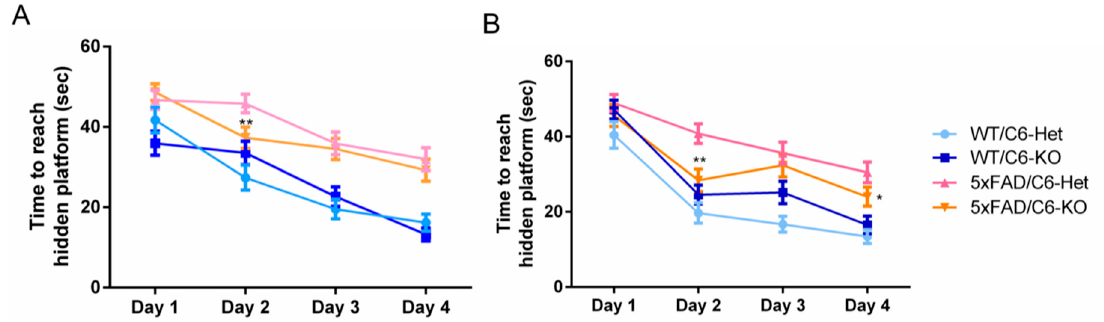
Figure 2. Caspase-6 KO in 5xFAD mice improves cognitive performance in the Morris water maze test.